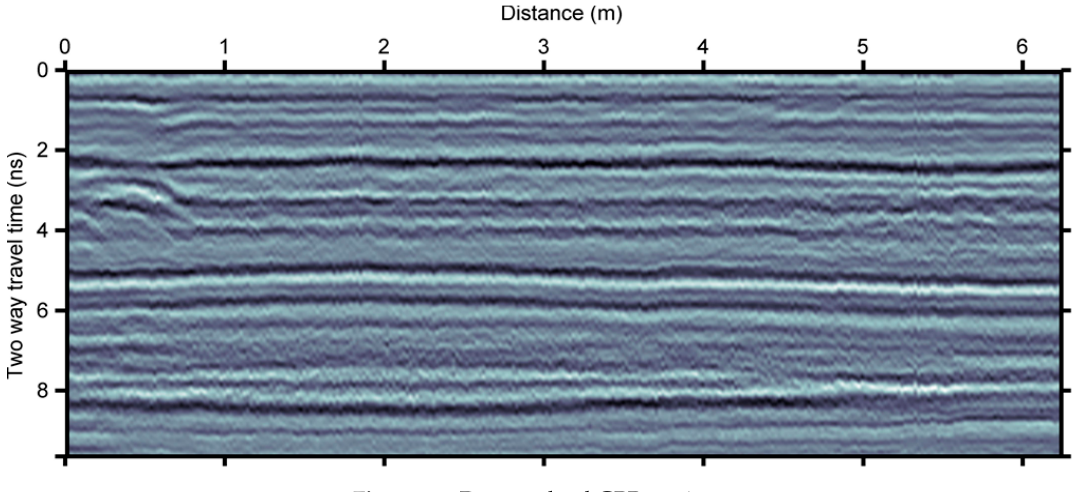
Figure 10. Deconvolved GPR section.